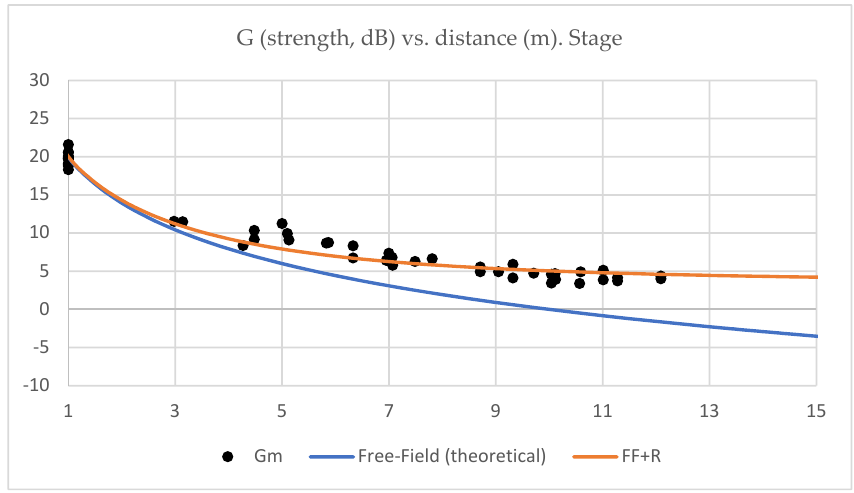
Figure 7. G m on stage versus source–receiver distance (m). Free-field values for comparison. Figure 7. Gm on stage versus source–receiver distance (m). Free-field values for